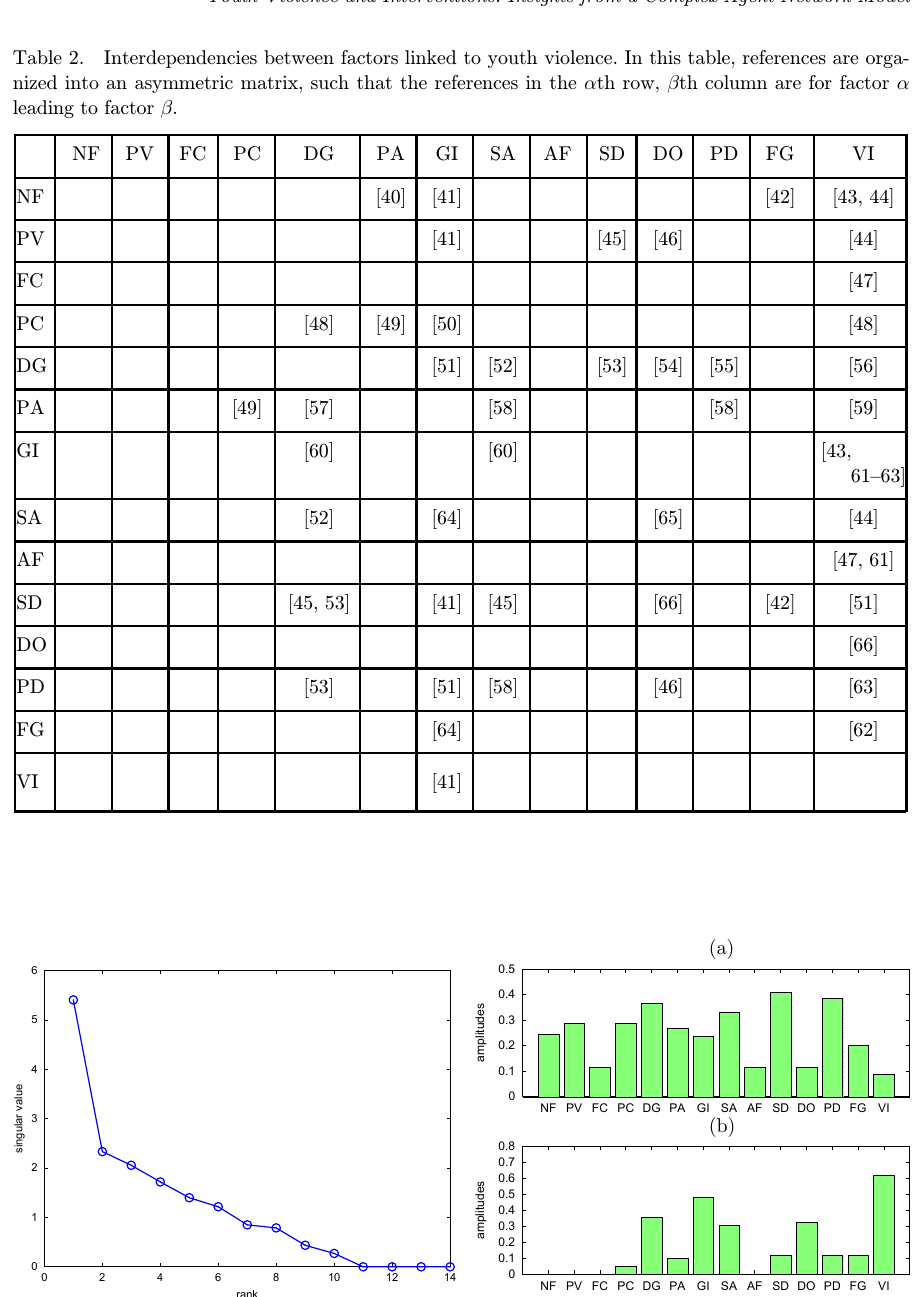
Fig. 3. (left) Singular values of the factor network shown in Fig. 2(b). The ¯rst singular value is sig- ni¯cantly larger than the other nine nonzero singular values. (right) First-principal-component amplitudes of (a) the most in°uential factors, and (b) the most in°uenced